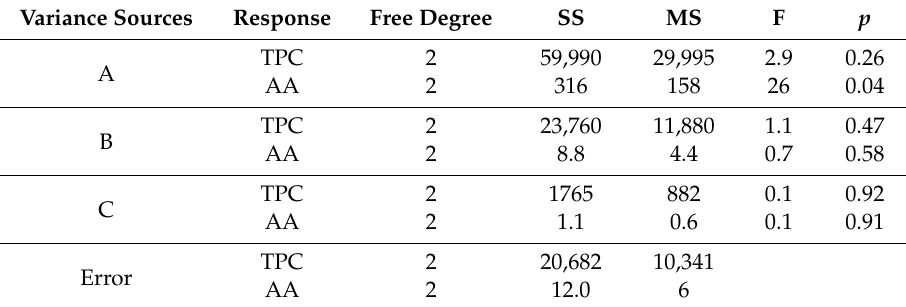
Table 4. Variance analysis of L 9 (3 4 ) orthogonal experiment for extrusion.